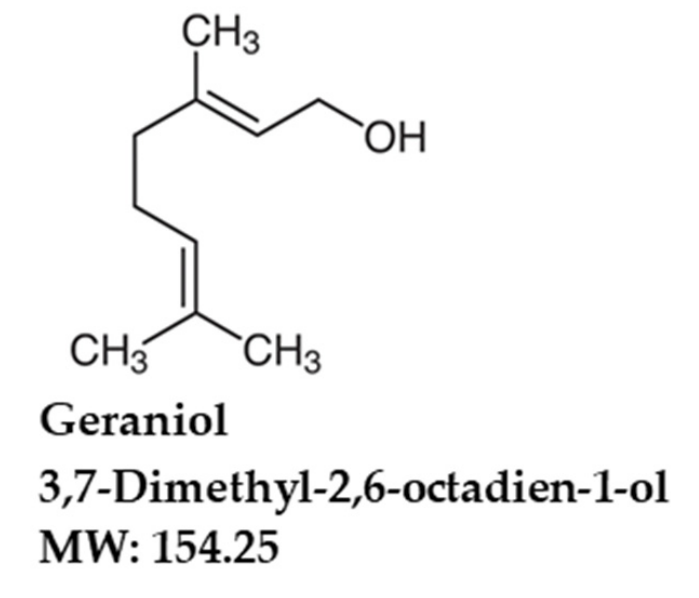
Figure 1. Chemical structure of geraniol (GNL).